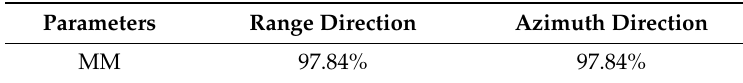
Table 3. MM between the original image and the reconstructed image.